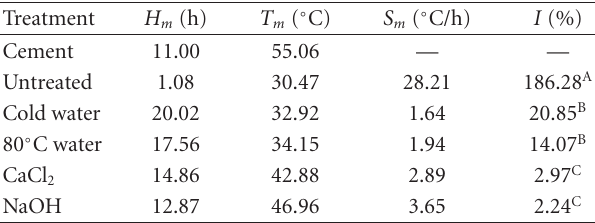
Table 2: Inhibitory index of coir fibre mixed with Portland